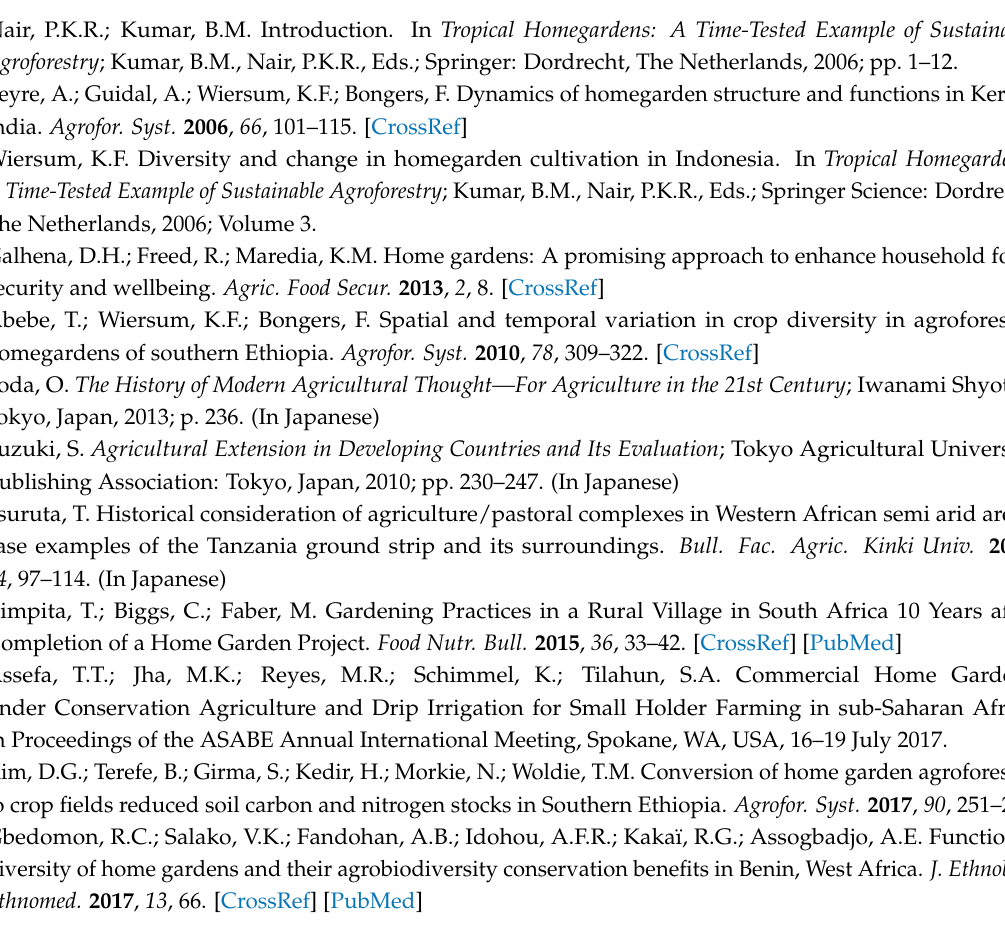
Table S1: Information on household members who have lived together at a homegarden and characteristics of cropping patterns of each